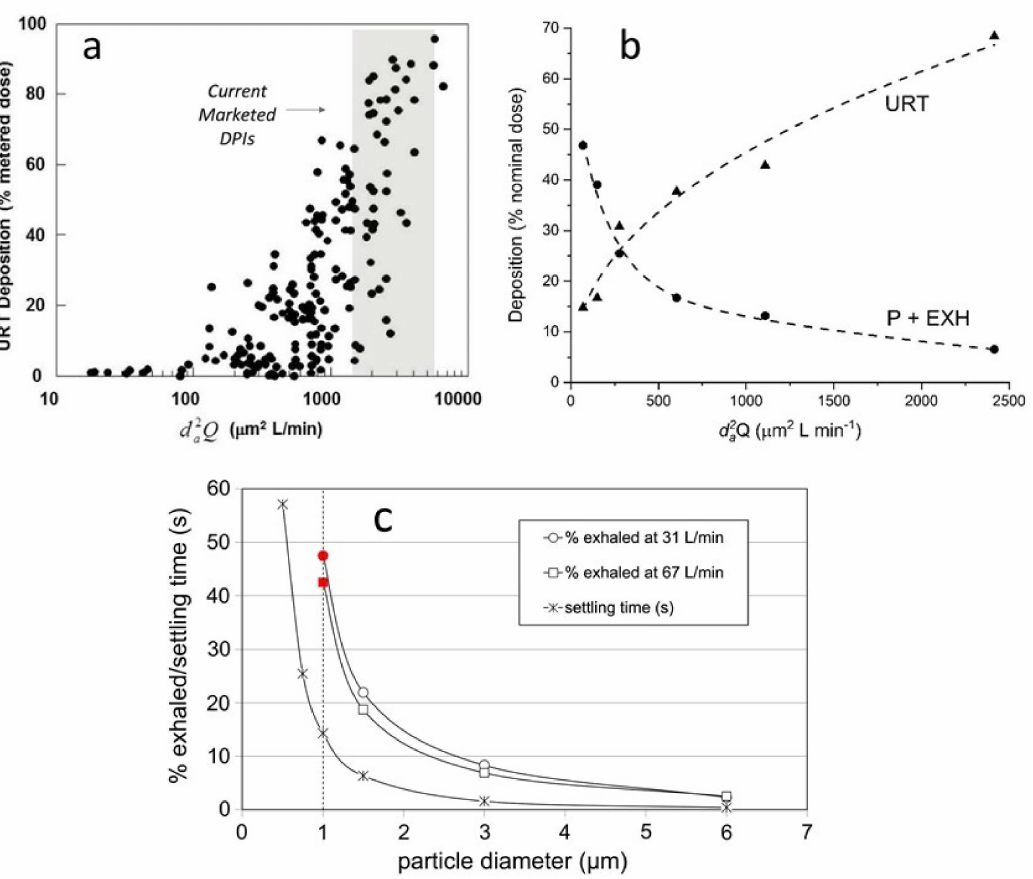
Figure 1. Particle deposition and exhalation in adult subjects as a function of variations in the impaction parameter, d 2 a Q and d a : ( a ) data for monodisperse liquid aerosols from Stahlhofen et al. [8,9]; ( b ) plot constructed from results of Usmani et al. for delivery of monodisperse particles of albuterol to adult subjects with mild asthma [28]; ( c ) comparison of the particle fraction exhaled and the time needed to sediment a distance 0.43 mm in a respiratory bronchiole at a stationary settling velocity. Both curves share the same ordinate. The figure is also constructed from results of Usmani et al.’s study [28] and extrapolated to 1 µ m particles